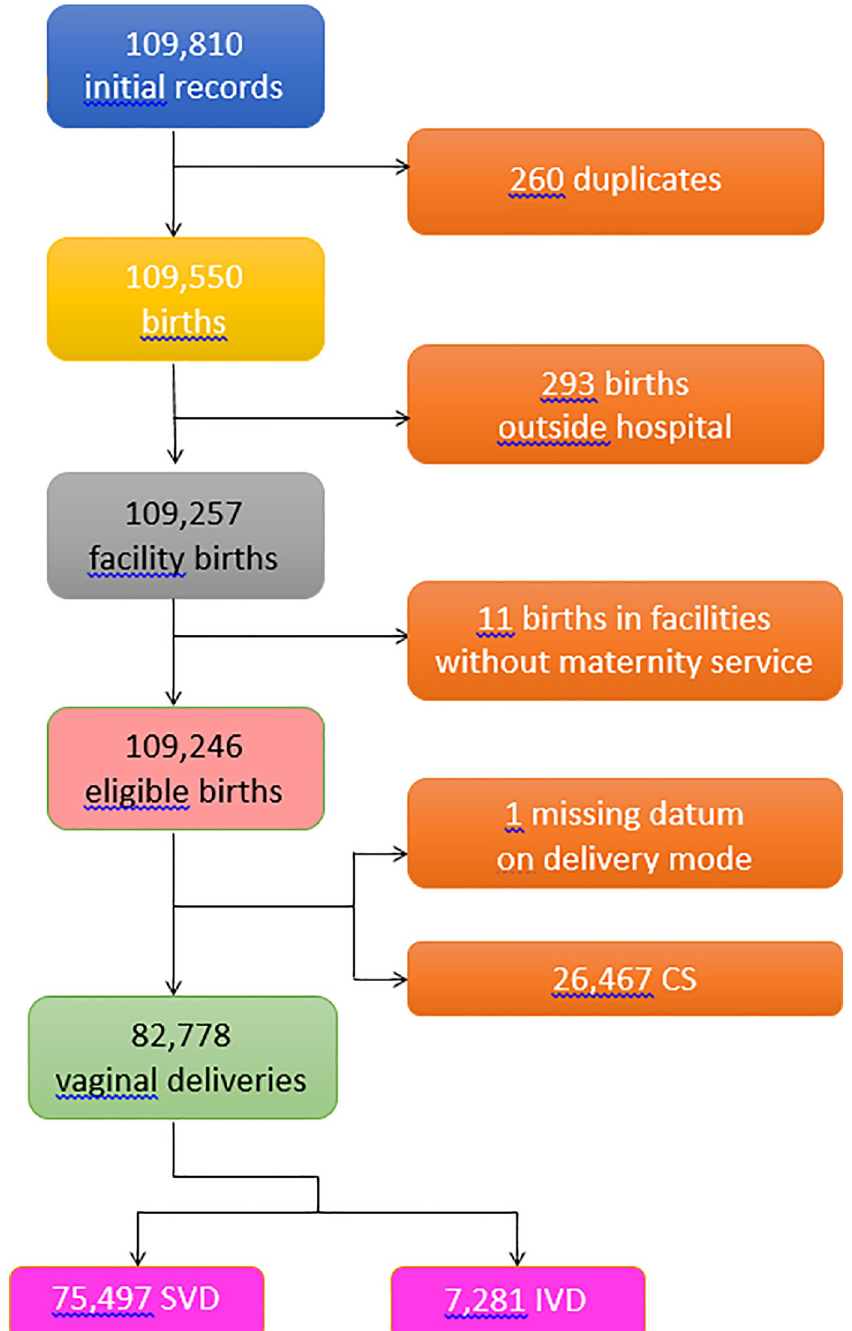
Fig 1. Flowchart displaying the various criteria applied to the initial database to obtain the final number of hospital records available for the analysis. SVD = spontaneous vaginal deliveries; IVD = instrumental vaginal deliveries; CS = cesarean